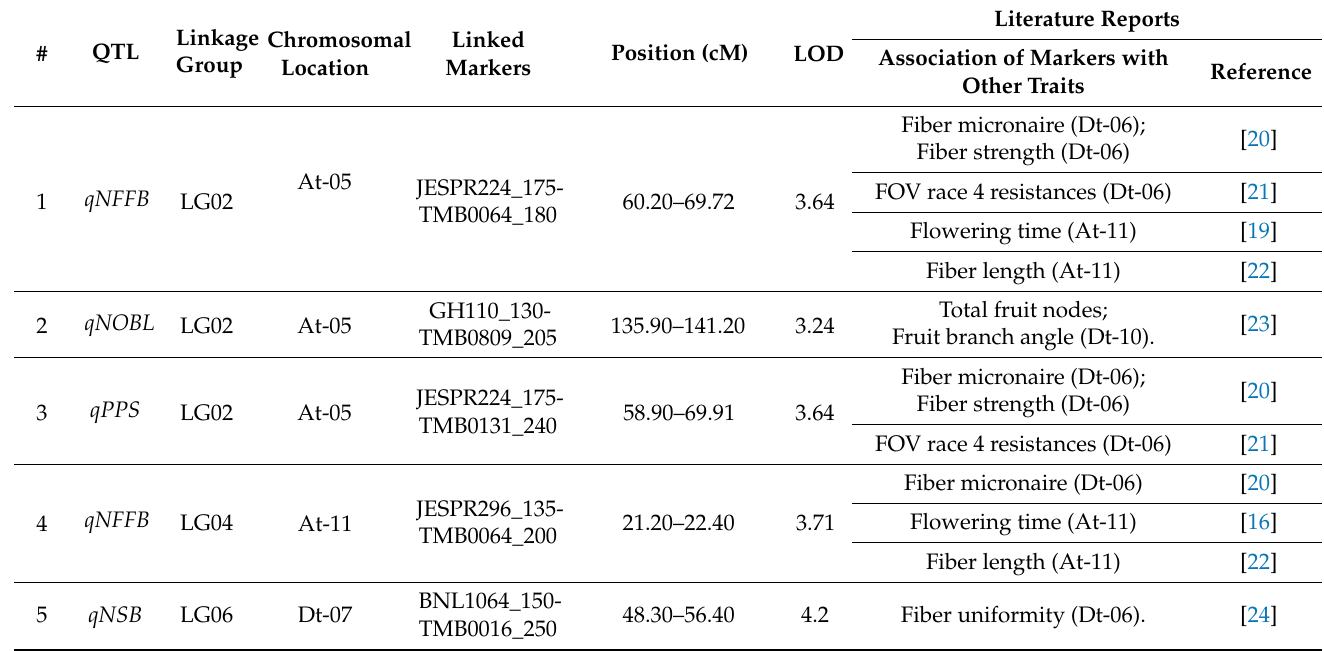
Table 5. Genomic distribution of SSR markers and QTLs related to flowering time and morphologi- cal